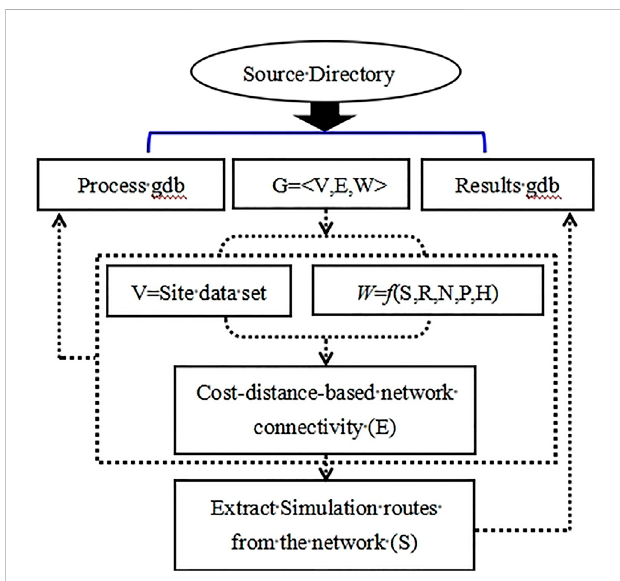
FIGURE 2 Flowchart showing work fl ow for calculation of elements in the exchange route simulation. G is a weighted network, E is a network connection,Wisthecost,Sistheoptimalpath between nodesV.Sisthe slope, R is the river, N is NDVI, P is NPP, and H is altitude. The calculation was designed using the Geographic Information Systems software ArcGIS (ESRI Corporation, Red lands, CA, United States) and executed in Python using the native Python geoprocessing tools in